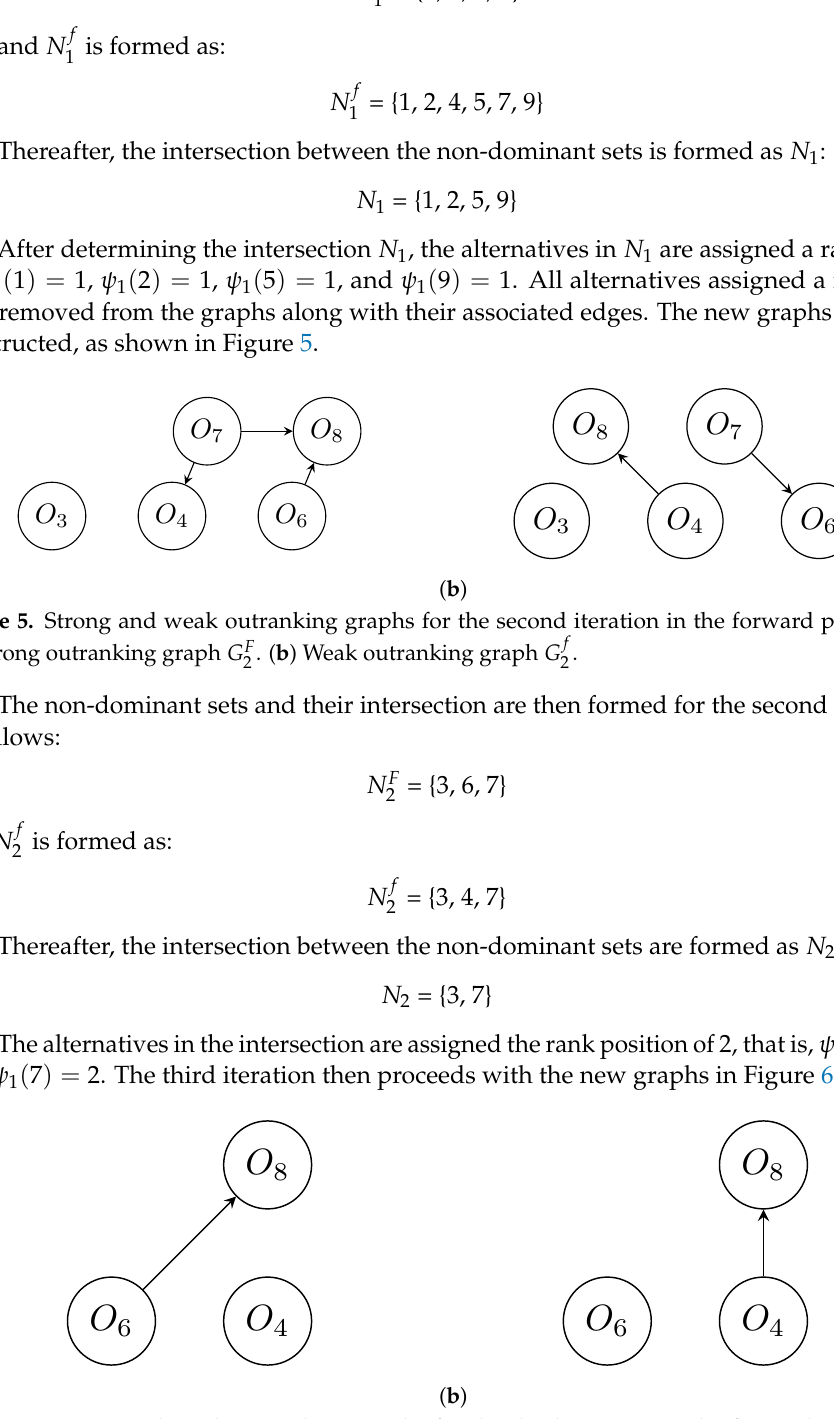
Figure 6. Strong and weak outranking graphs for the third iteration in the forward procedure. ( a ) Strong outranking graph G F . ( b ) Weak outranking graph G f 3 3